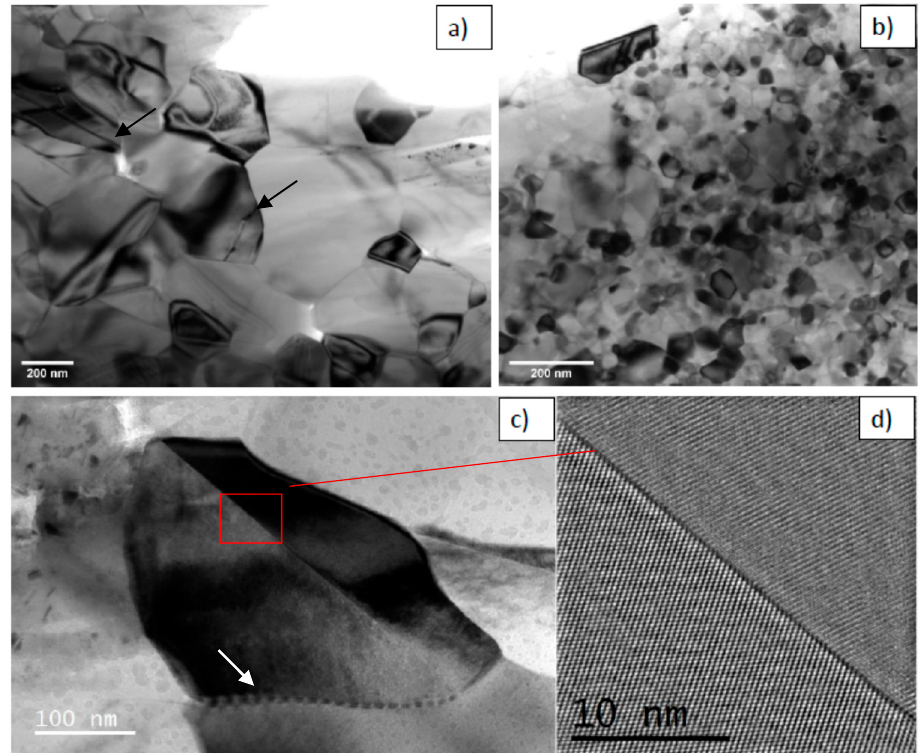
Figure 12. TEM images of samples sintered at 700 °C under 400 MPa. The black arrow shows fractured grains ( a ) and 76 MPa ( b ); grain comprised of twinned crystals, observed in the sample sintered under 400 MPa. The white arrow shows an intragranular dislocation fold originating from a triple point ( c ); high resolution TEM image of the twin boundary ( d ).